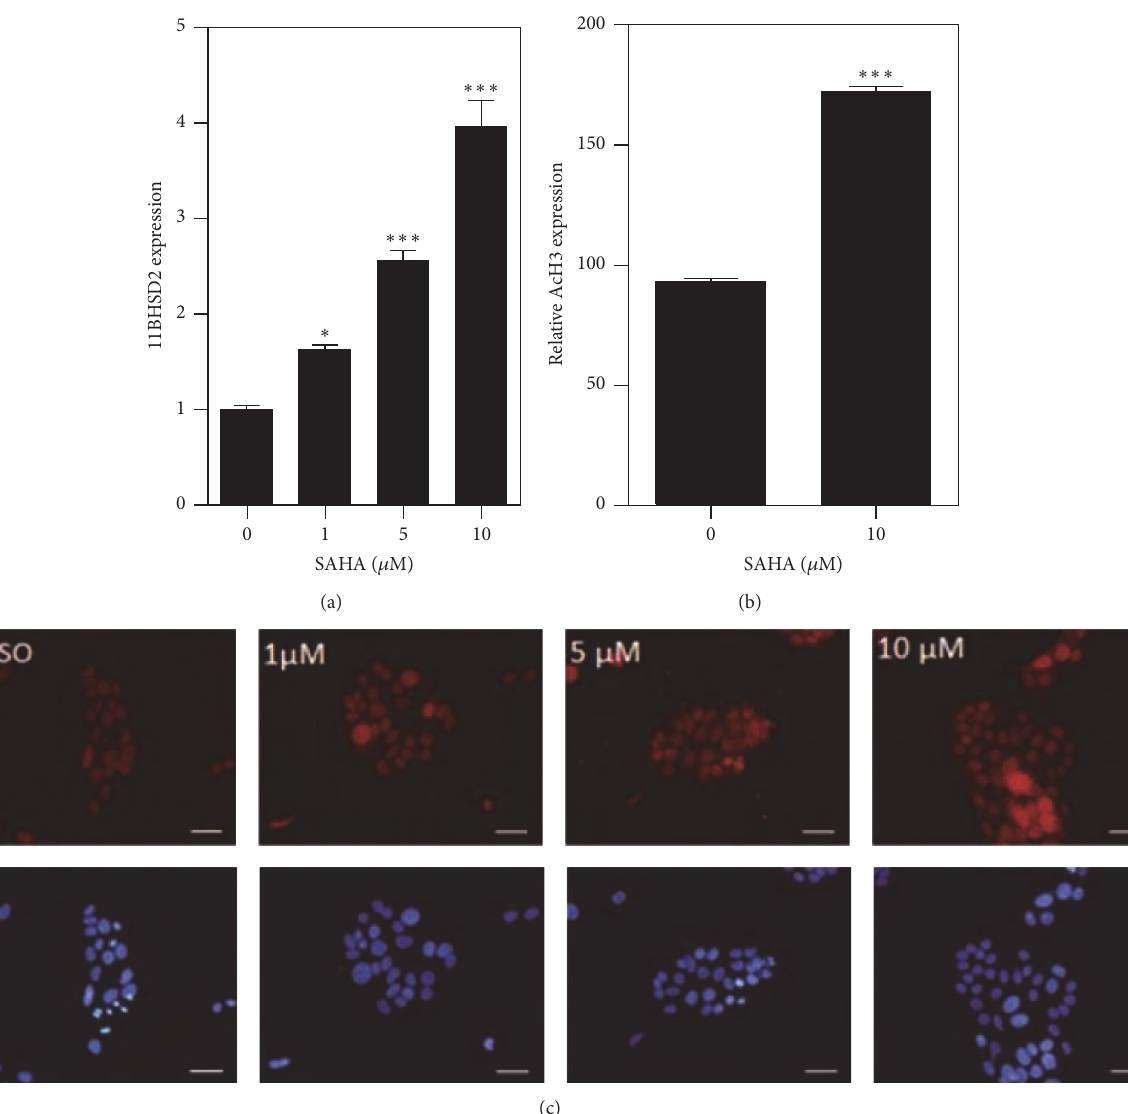
Figure 2: Epigenetic regulation of 11 𝛽 -HSD2 expression. Graphical representation of (a) 11 𝛽 -HSD2 and (b) AcH3 expression in JEG-3 cells treated with 0–10 𝜇 M of SAHA for 24 h. Data are expressed as mean ± SEM. (c) Representative photomicrographs of JEG-3 cells immunocytochemically stained for 11 𝛽 -HSD2 ( ∗ 𝑝 < 0.05 , ∗∗∗ 𝑝 < 0.001 compared to 0 𝜇 M; (a) one-way ANOVA with post hoc Tukey’s and (b) unpaired Student’s 𝑡 -test; 25 cells per group per experiment; 𝑁 = 3 ). Scale bar = 50 𝜇